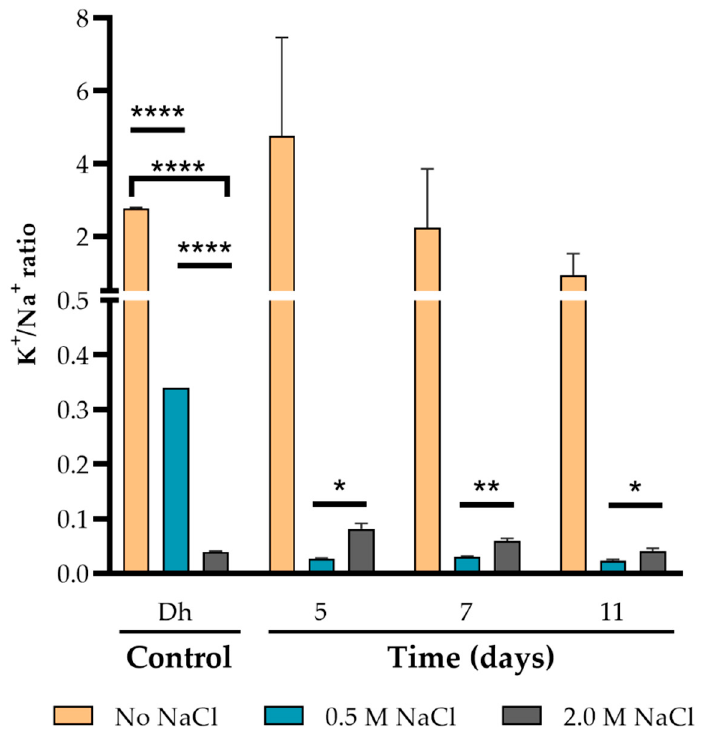
Figure 7. Regulation of intracellular K + /Na + ratio in response to salinity in A. sydowii cells. Dh: Debaryomyces hansenii was used as a positive control. Data are means ± SD. Statistical significance was determined using the Holm-Sidak method, with alpha = 0.05. Each row was analyzed individually, without assuming a consistent SD. (* p < 0.05, ** p < 0.01, **** p < 0.0001).